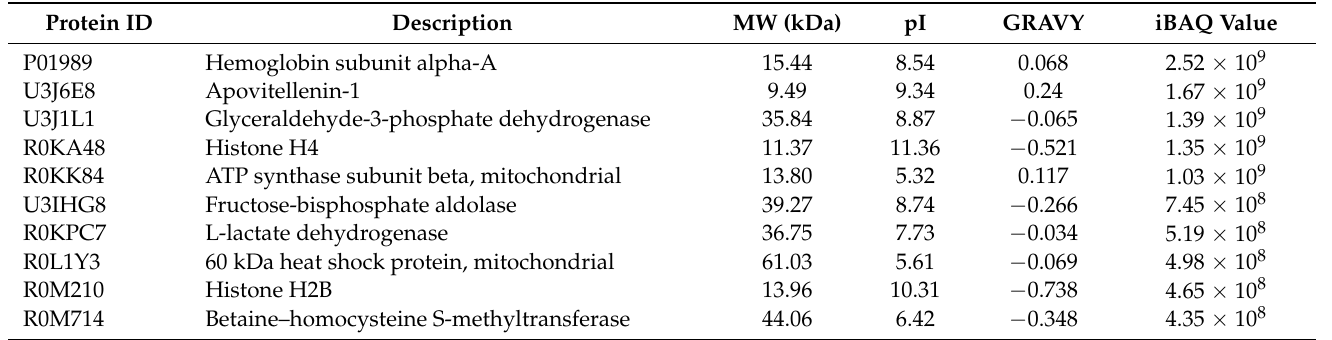
Table 3. Rank of the top 10 proteins of the highest signal strength in the PSGP group.